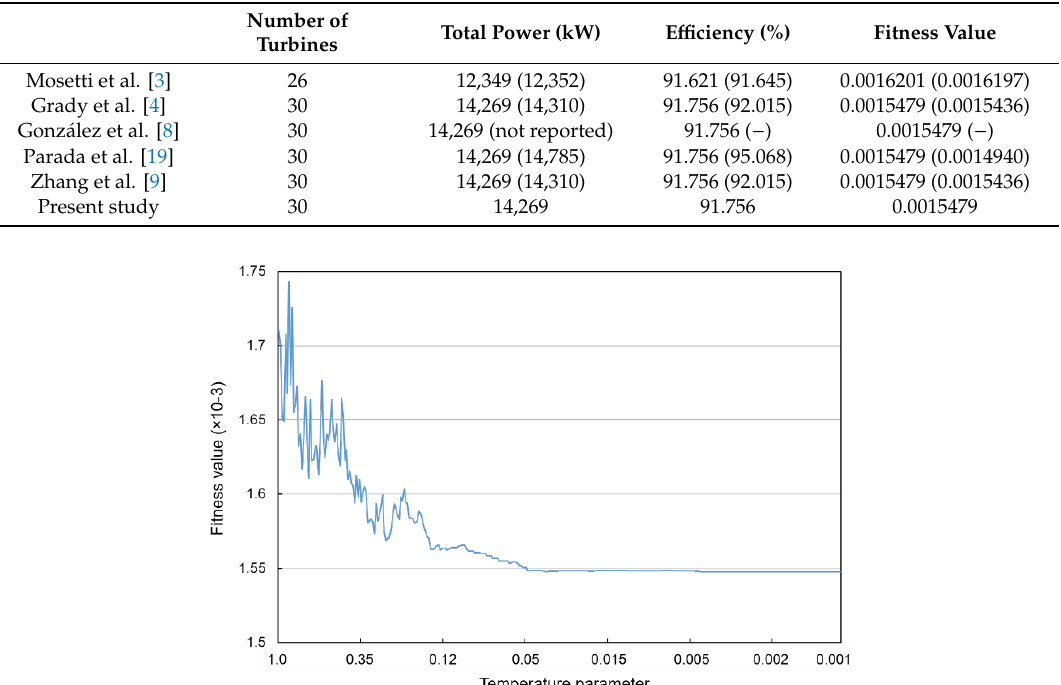
Figure 6. Fitness variation during the process in case study (a). Table 3. Layout Results for Case Study (a).